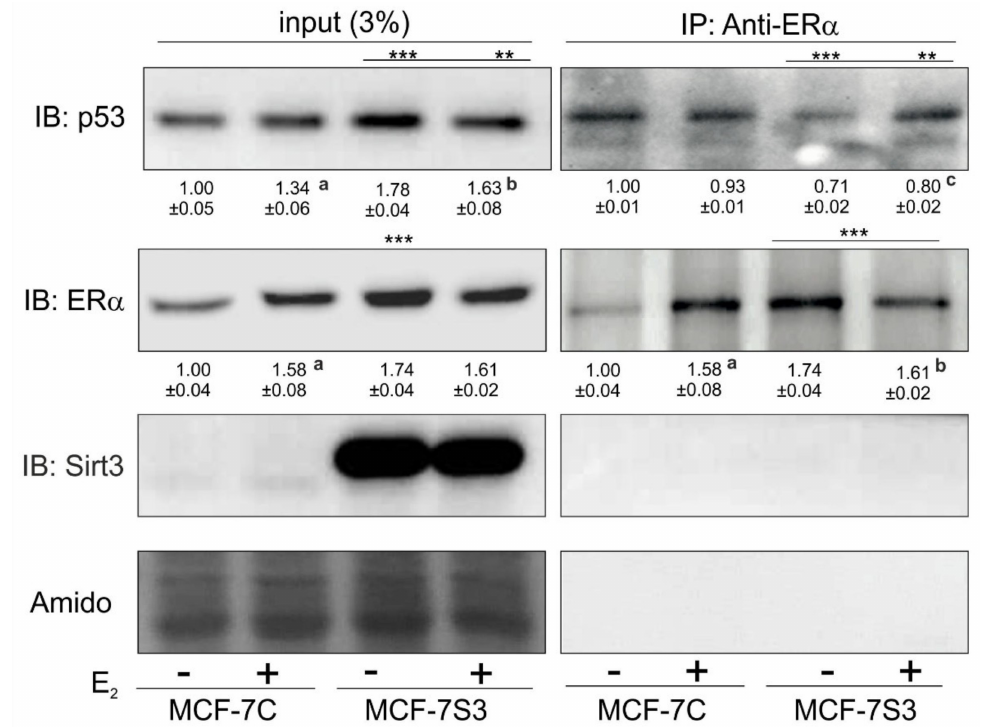
Figure 7. Sirt3 induces disruption of the ER α –p53 interaction in MCF-7 cells. Western blot analysis of coimmunoprecipitation experiment of ER α and its interacting partners using anti-ER α and anti-p53 antibody. For input p53, MCF-7C + E2 vs. MCF-7C ( a p < 0.001), MCF-7S3 + E2 vs. MCF-7S3 ( b p < 0.01), the MCF-7S3 control vs. MCF-7C (*** p < 0.001), MCF-7S3 + E2 vs. MCF-7C (** p < 0.01). For input ER α , MCF-7C + E2 vs. MCF-7C ( a p < 0.01), MCF-7S3 vs. MCF-7C (*** p < 0.001). For IP-ER α , a control